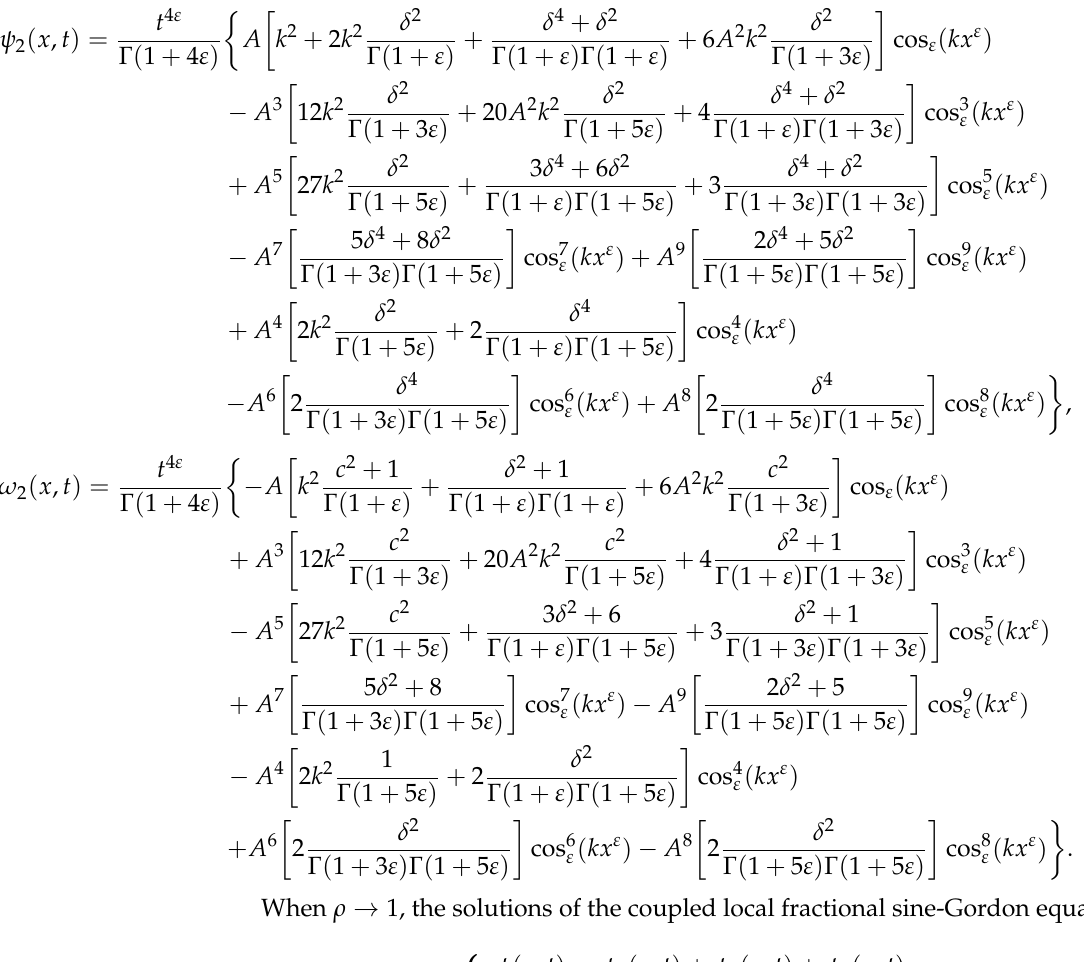
When the fractal dimension is ε = ln 2/ ln 3, the corresponding diagrams of ψ ( x , t ) and ω ( x , t ) are as shown in Figures 1 and 2.